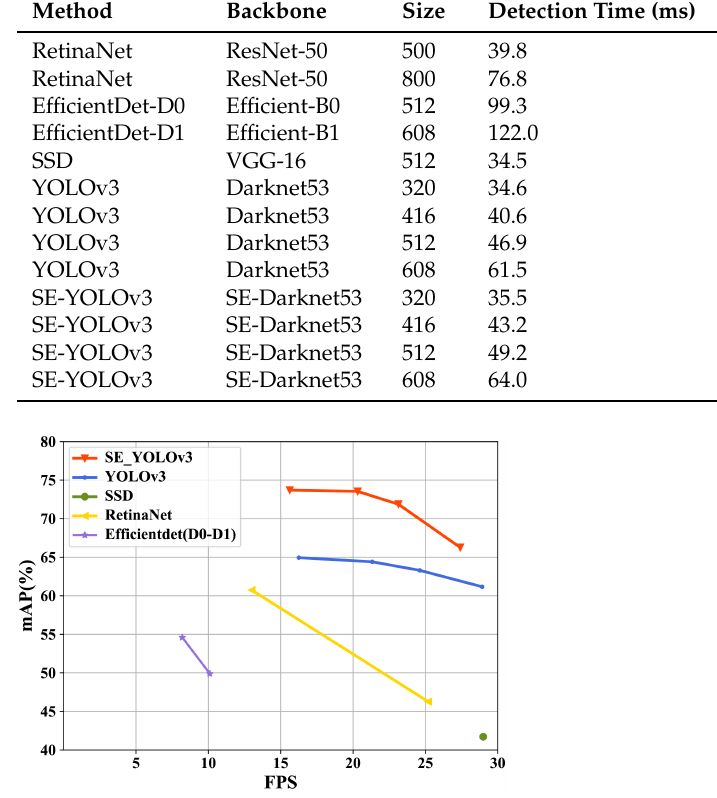
Figure 7. The speed/accuracy tradeoff of the proposed SE-YOLOv3 and other SOTAobject detectors. SE-YOLOv3 can balance the accuracy and detection speed